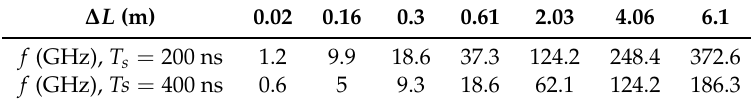
Table 2. Estimated frequencies for T s = 200 ns and Ts = 400 ns and OPDs ∆ L from Table 1. ∆ L